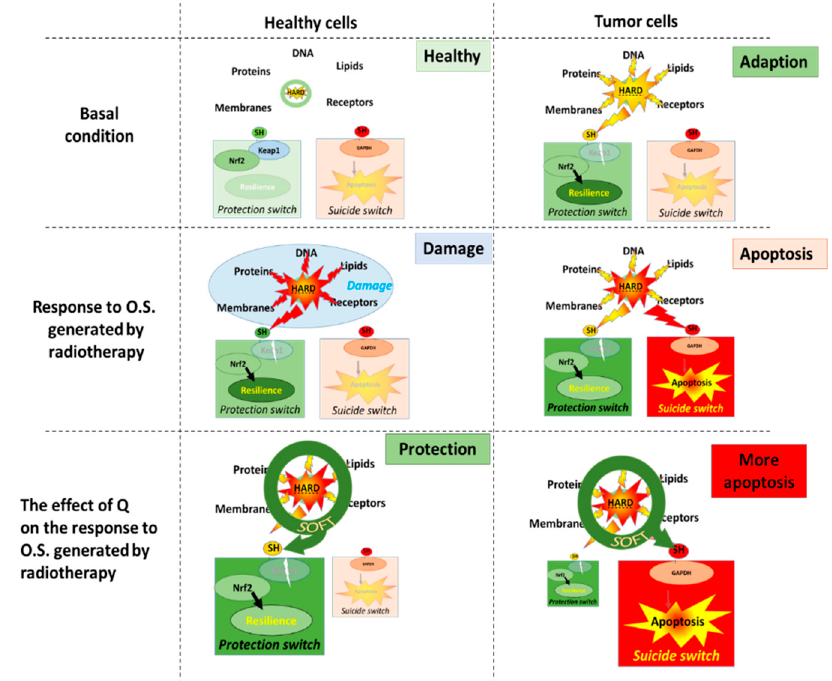
Figure 4. The molecular mechanism that underlies our hypothesis on the difference in the effect of quercetin (Q) on healthy cells and tumor cells. In basal conditions, there is a redox equilibrium be- tween oxidative stress and antioxidant protection. Radiotherapy will damage healthy cells, although the cells will adapt by turning on the protection KEAP1 switch. In healthy cells, Q will prevent damage and increase the protective response, which will increase the resilience of these cells. In tumor cells, the adaptive switch is already turned on in the basal condition. This reduces the efficacy of antitumor therapies which are aimed to induce apoptosis. In tumor cells, Q increases the efficacy of antitumor therapies by turning on the emergency GAPDH suicide switch that induces apoptosis. KEAP1, Kelch-like ECH-associated protein 1; GAPDH, Glyceraldehyde-3-phosphate